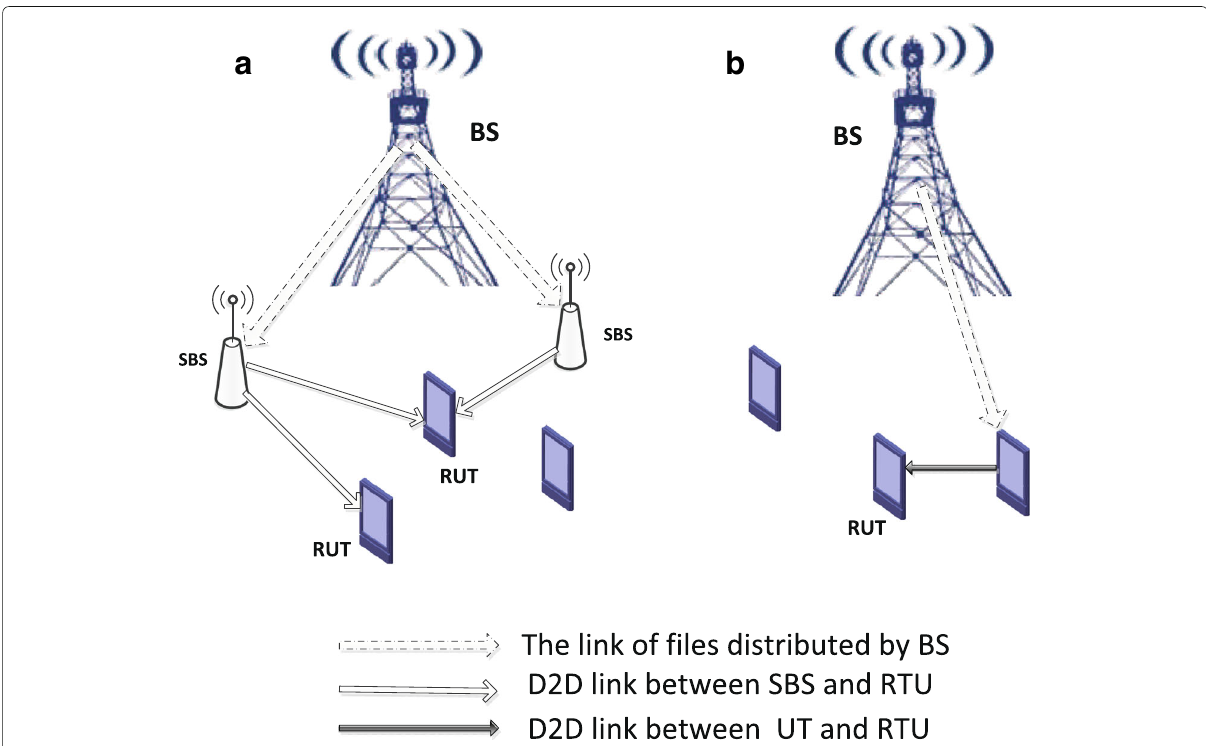
Fig. 1 Two main cache perspectives of D2D communication considering different placement devices. This figure shows the existing D2D communication schemes, which can be classified into two categories by taking into account different devices to implement local-storage, i.e., the mode of UTs or SBSs to carry out offloading. a Example of SBS offload, b Example of UT